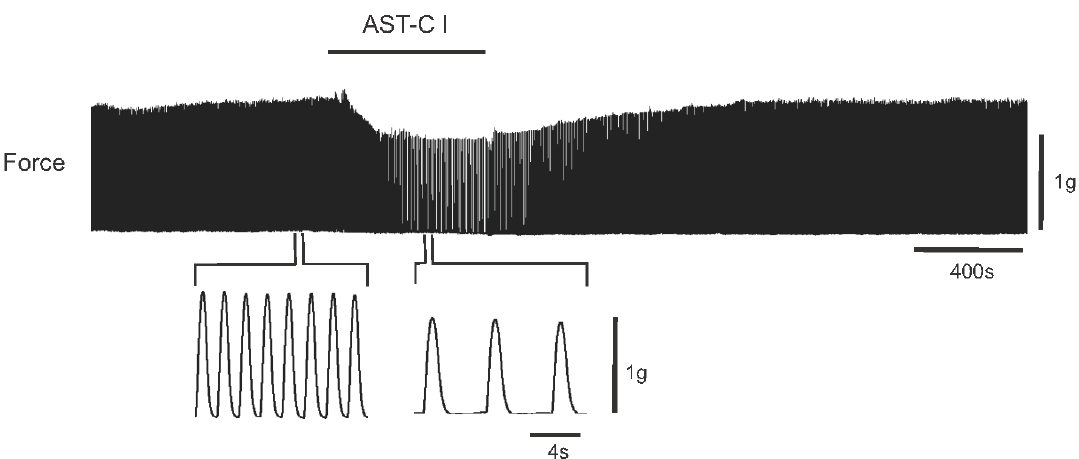
Figure 6. AST-C I modulates the contraction amplitude of the H. americanus heartbeat. In this sample recording, the perfusion of AST-C I through the heart caused the contraction amplitude to decrease; however, AST-C I can also cause an increase in contraction amplitude. The heartbeat returned to the baseline amplitude when the peptide was washed out.